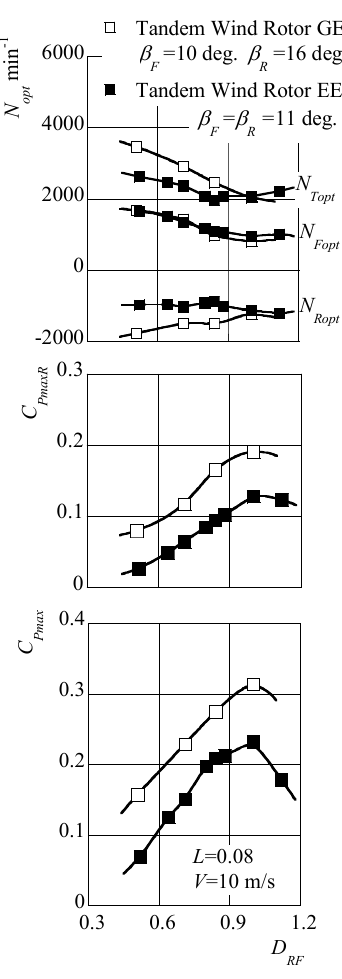
Fig.6 Effect of the diameter ratio on the output characteristics